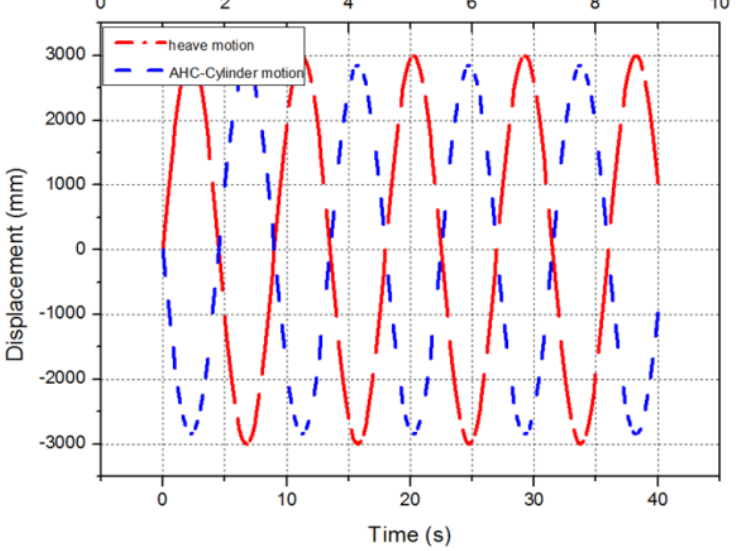
Figure 4. Motion of heave and the AHC cylinder.